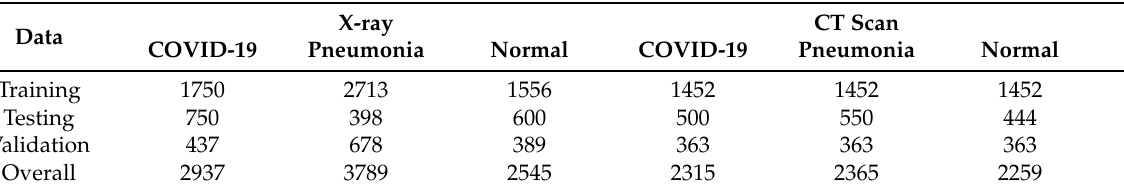
Table 1. The data set used in the experiment.